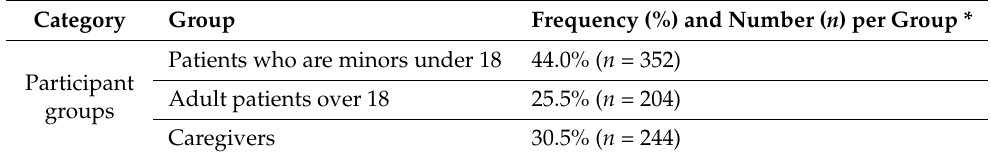
Table 1. Descriptive information of study